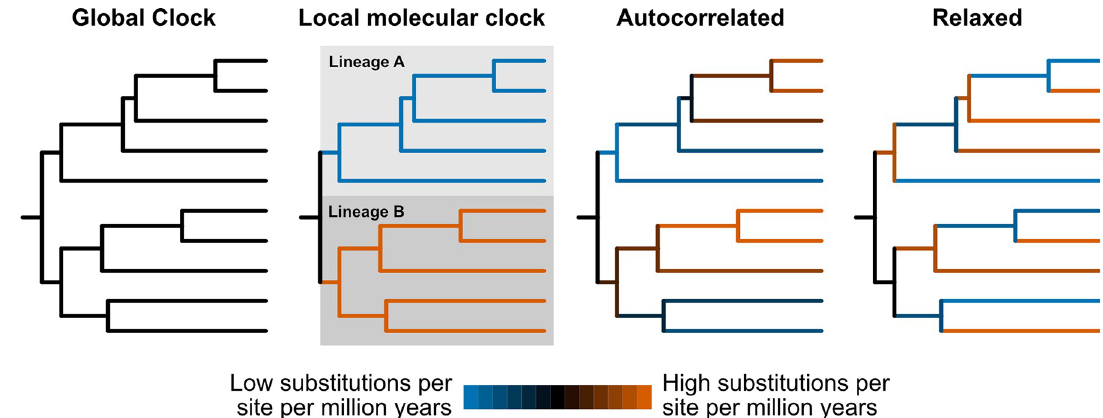
Fig 1. Cartoon representations of different clock models. Global clocks impose the same substitution rate across the phylogeny. Local clocks use the same substitution rate for user-defined lineages. Autocorrelated clocks assume that substitution rates gradually change across speciation events resulting in closely related lineages having similar rates. In relaxed clocks—the critical component of relaxed phylogenetics—the substitution rate of each branch is independent of other branches.